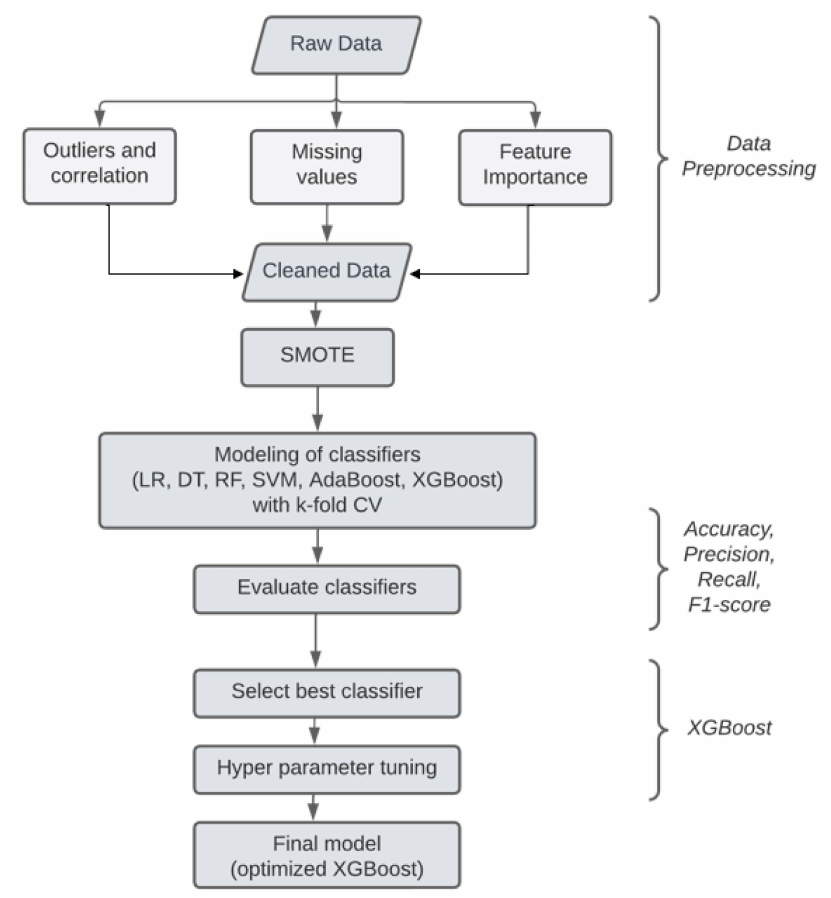
Figure 1. Stages involved in this